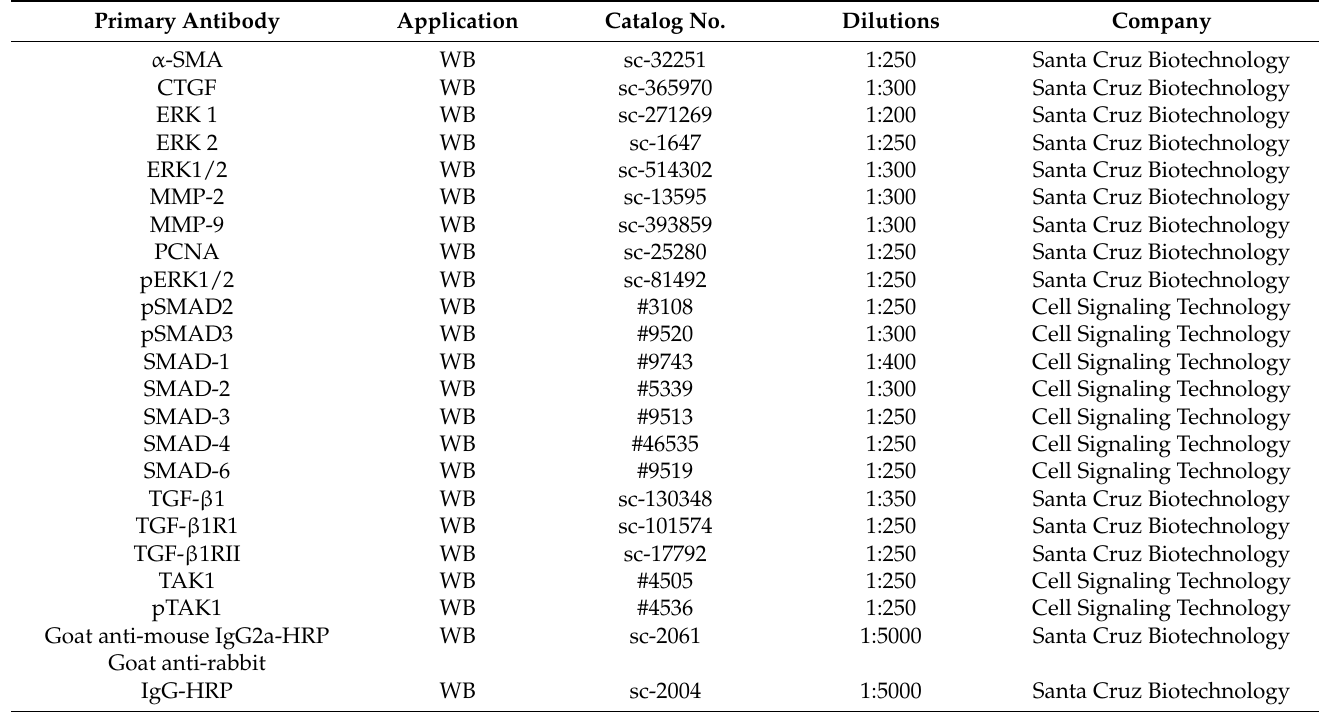
Table 1. List of antibodies used in the present studies, which are indicated with their application, catalog number, respective dilutions, and names of vendors of commercial